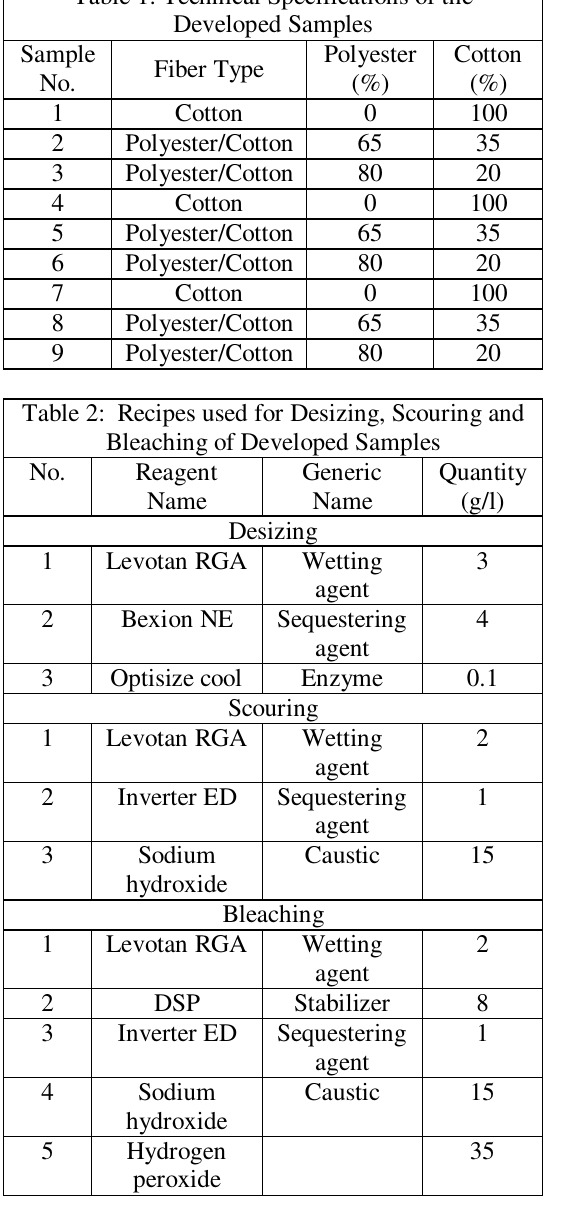
Table 1: Technical Specifications of the Developed Samples